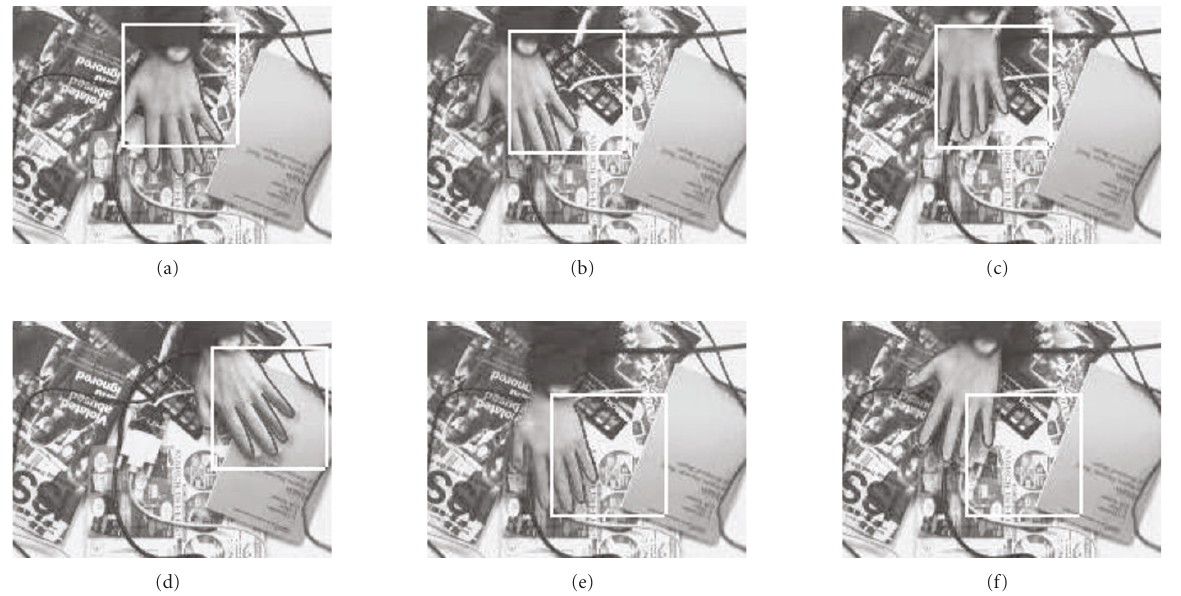
Figure 16: Tracking a hand moving on a cluttered table with Tracker D using only luminance at time t = 16,29,37,53,66,78.